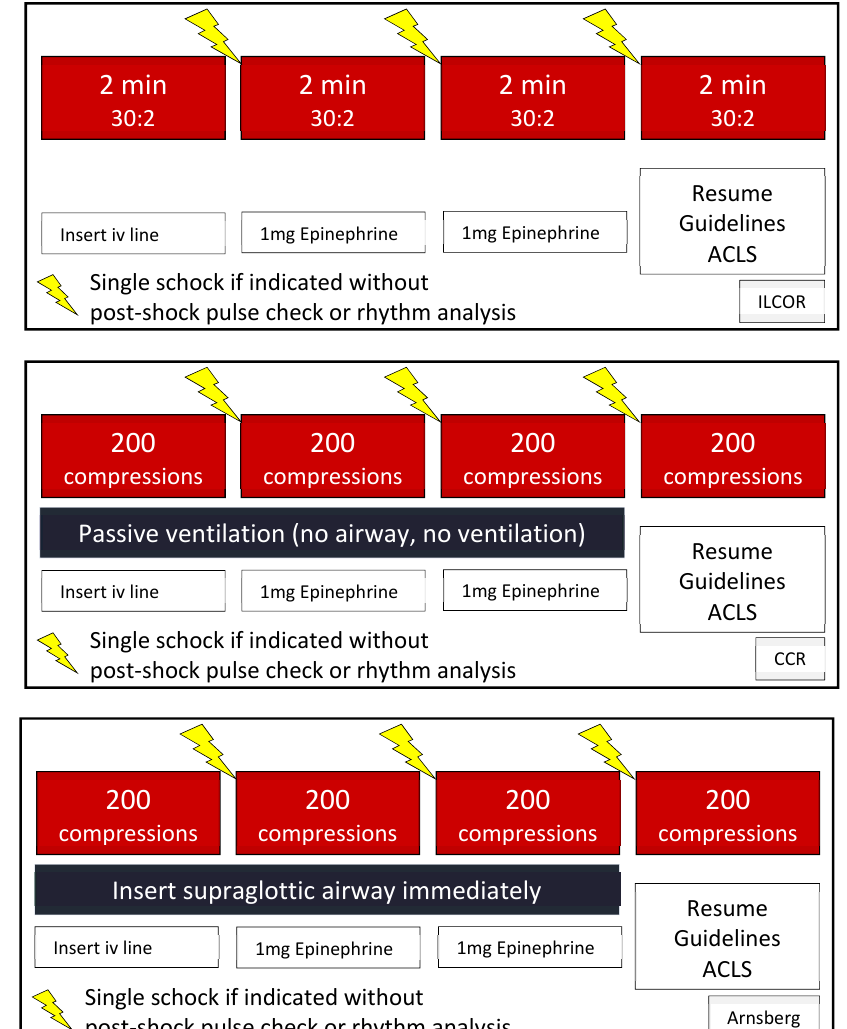
Figure 1. Graphical instructions handed to the participants prior to the simulated cardiac arrest. Top panel: version distributed to “ILCOR” teams. Middle panel: version distributed to the “CCR” teams. Lower panel: version distributed to the “Arnsberg” teams.